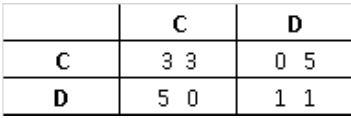
An exemplary payoff matrix of a game of enforceable cooperation